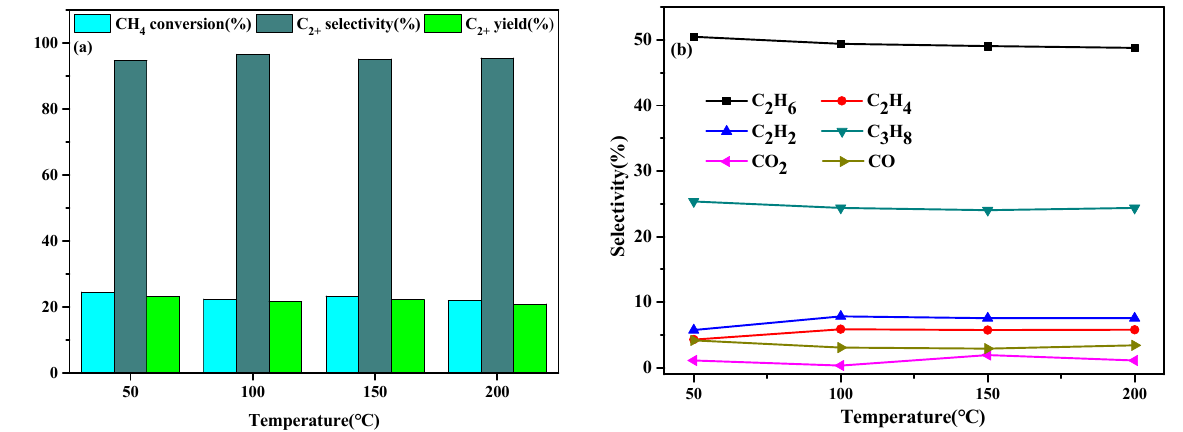
Figure 6. Effect of temperature on the catalytic performance of the MnTi catalyst in DBD plasma. ( a ) Oxidative coupling performance; ( b ) product distribution (flow rate: 60 mL/min, applied voltage: 100 V).